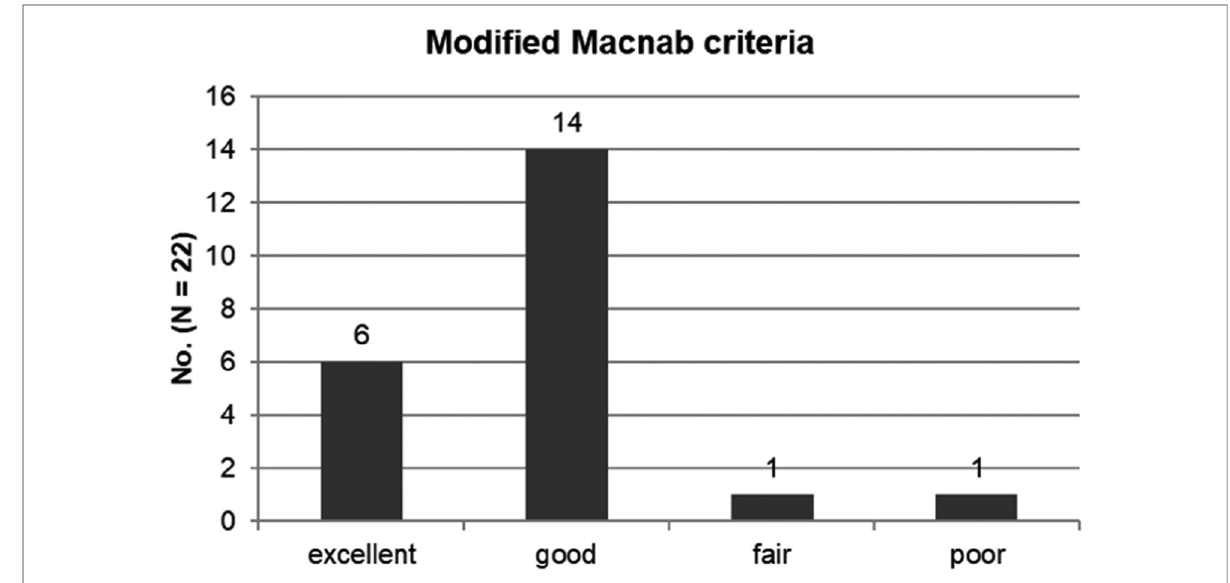
FIGURE 6 The global outcome according to the modi fi ed macNab criteria: excellent in 6 patients (27. 3%), good in 14 (63.6%), fair in 1 (4.5%), and poor in 1 (4.5%). Therefore, the success rate was 90.9%, and the clinical improvement rate was